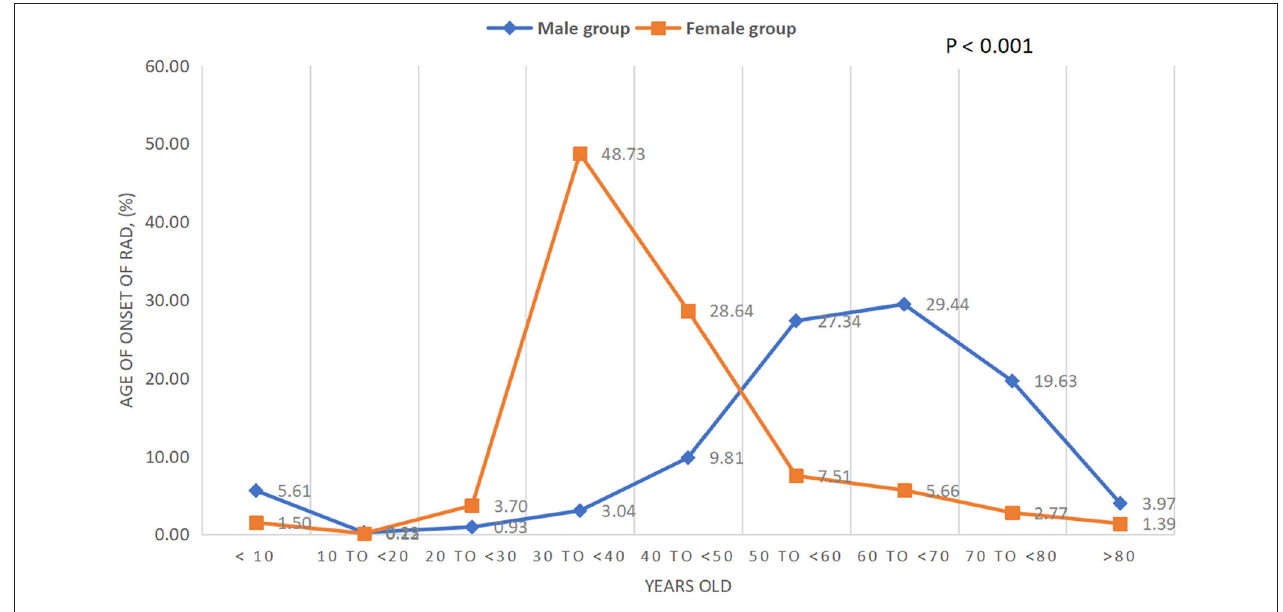
FIGURE 1 | Age at onset of